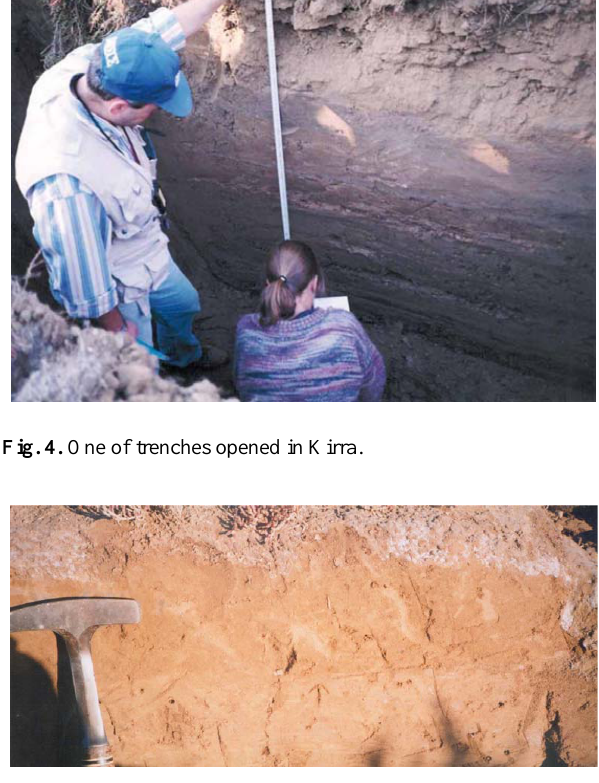
Fig. 5. The very thin (0.5–4cm) upper sand layer in Kirra, marked by an arrow showing upwards and four sand dykes, which pene- trate into the overlying silts suggesting soil liquefaction during an earthquake event, very possibly the 1 August 1870 one.